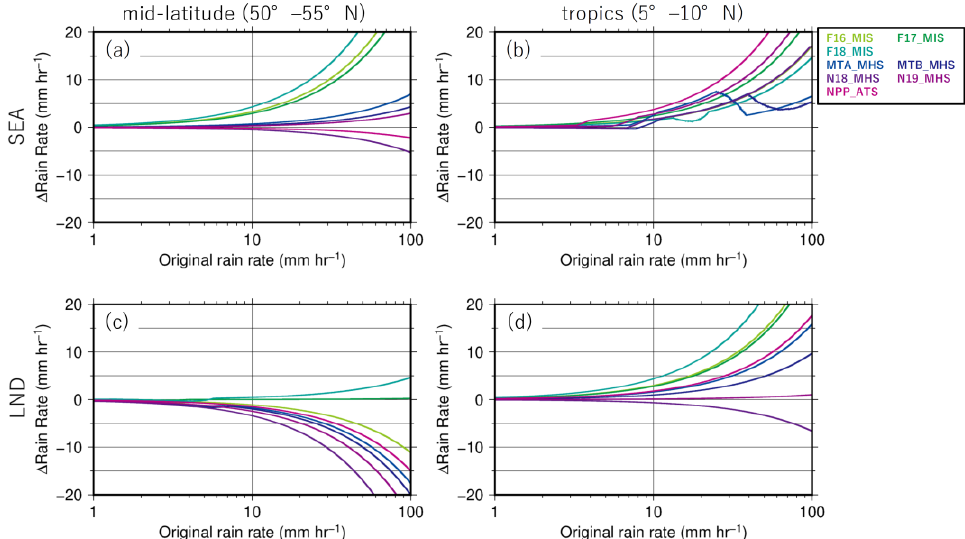
Figure 3. Relationship of the rain rate before the MMN correction ( x -axis) and the rain rate difference from the corrected to uncorrected ( y- axis) MMN. in July 2014 in ( a ) 50° – 55°N and ( b ) 5° – 10°N over ocean. ( c , d ) are the same as ( a , b ) except for over land.